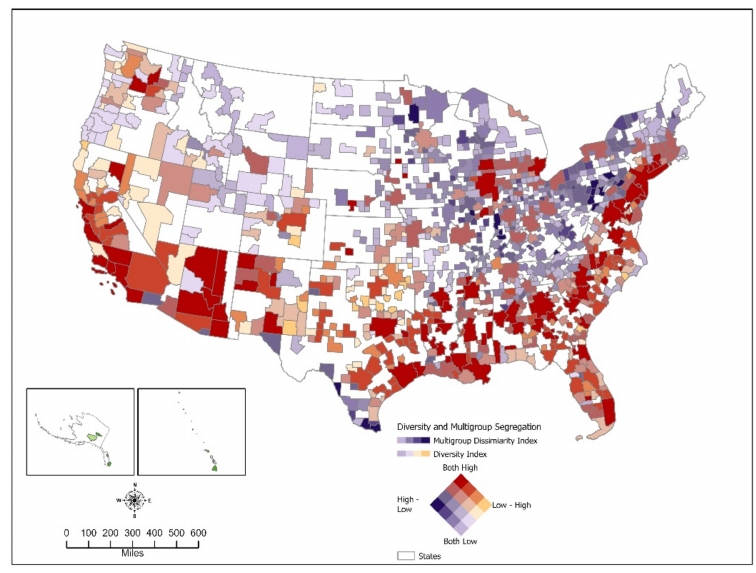
Figure A1. Joint Distribution of Racial Diversity and Multigroup Dissimilarity, 2020.